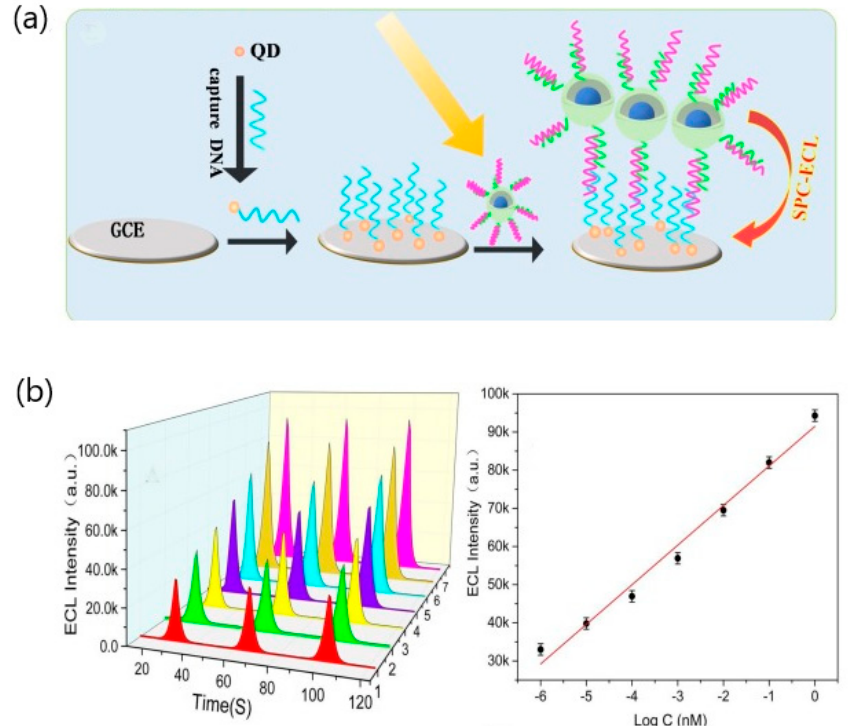
Figure 13. ( a ) The preparation process of magnetic-plasmonic Fe 3 O 4 yolk / Au shell (M@Au). ( b ) Schematic illustration of plasmon-enhanced, electrochemiluminescence (ECL)-sensing process (glassy carbon electrode (GCE), surface plasmon coupling (SPC)). The plasmon resonance peak of M@Au first red shifted from 521 nm to 548 nm and blue shifted from 548 nm to 531 nm. Adapted with permission from Zhang et al. [73] Copyright © (2020) Elsevier.